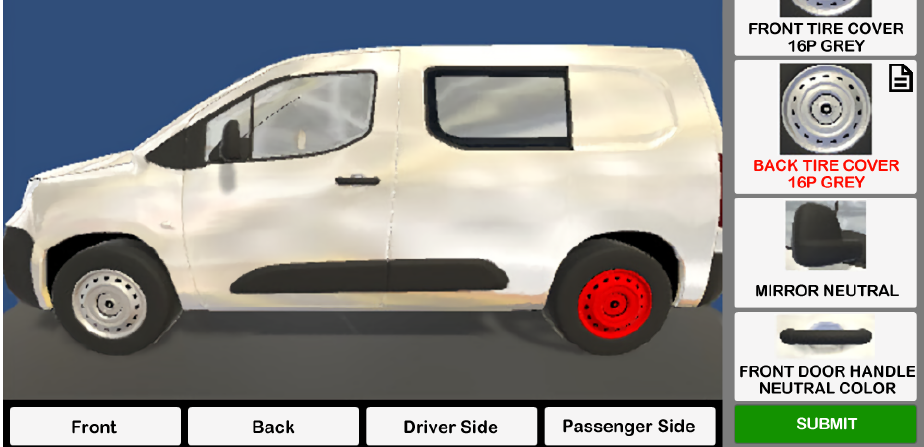
Figure 5. Smartphone design of the conformity list interface of the information visualization proto- type. The worker can use the four navigation buttons on the bottom to rotate the 3D representation of the fully conforming vehicle and compare it with its assembled counterpart. The list of scrollable part buttons on the right changes according to which face of the vehicle is being viewed. Any signaled non-conformity changes the color of the respective button and 3D part model to red, and adds a text and/or photo icon to the button as a visual reminder of the type of report the worker